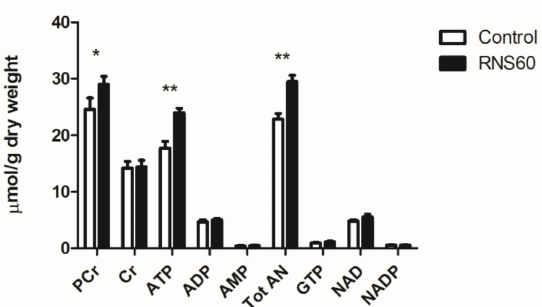
Figure 5. The myocardial concentration of nucleotide and creatine metabolites in the rat heart at the end of protocol involving 4 h of hypothermic (4 ◦ C) ischemia and 15 min of reperfusion in the control and group that received cardioplegia with RNS60. Values represent mean ± SEM (n = 5); * p < 0.01, ** p <